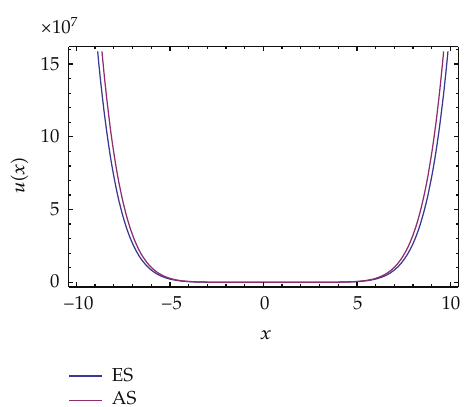
Figure 7: The compared results of the analytical and numerical solutions of Example 4.3 for t (cid:3) 0 . 5.